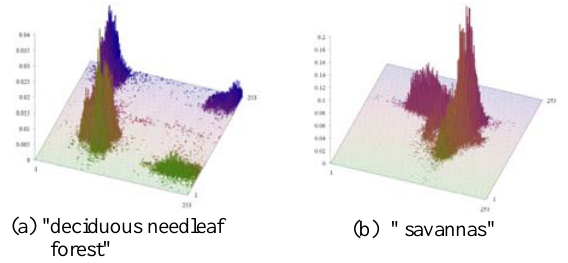
Figure 5. Training data example for "barren/sparsely vegetated".